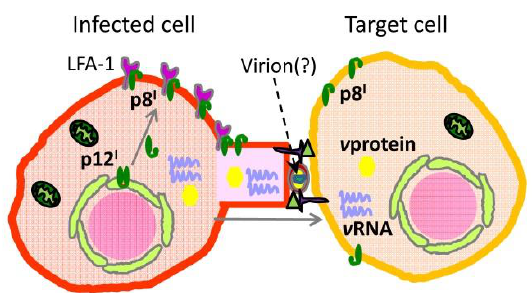
Figure 4. p8 I provides a mechanism for virus transmission through increased conduit formation: p8 I interacts with and enhances the clustering of lymphocyte function–associated antigen-1 (LFA-1) in the plasma membrane, and by doing so facilitates the contact between T cells. This results in the